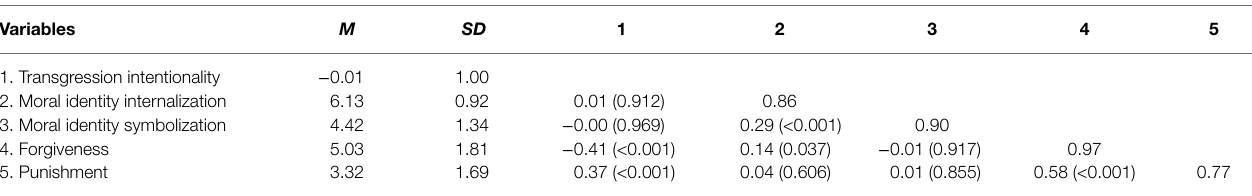
TABLE 1 | Descriptive statistics, correlations, and reliabilities, Study 2.